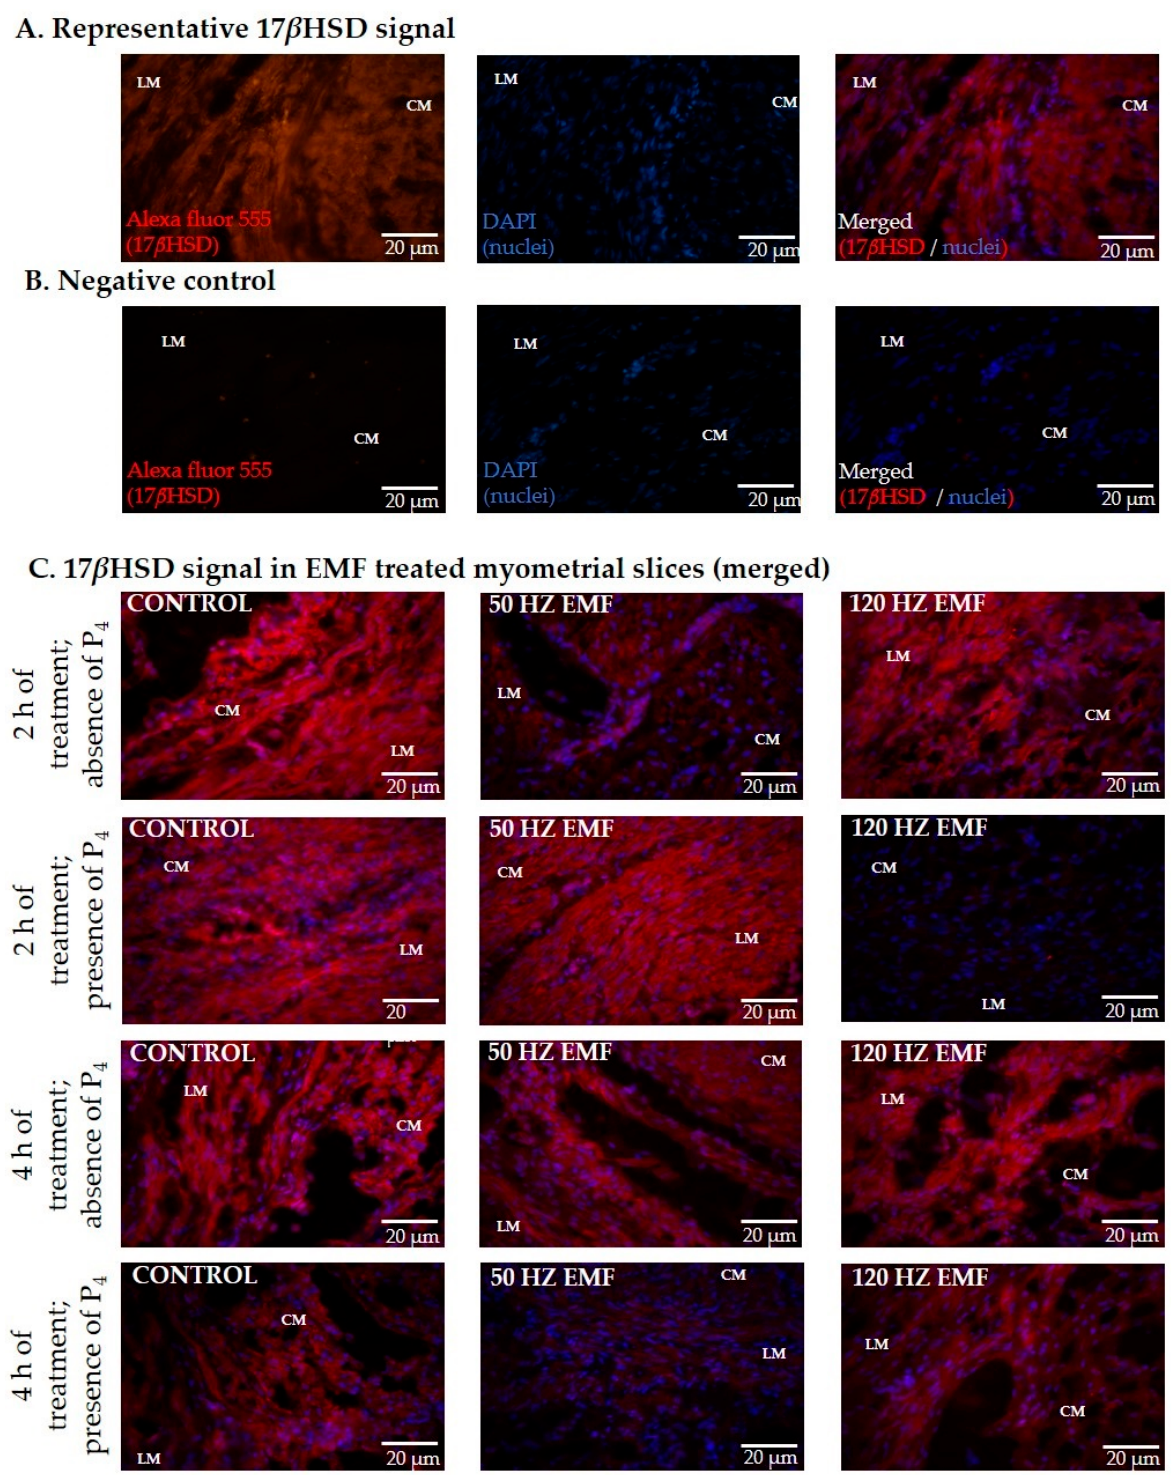
Figure 3. Randomly selected representative photographs of immunodetection of 17 β -hydroxysteroid dehydrogenase (17 β HSD) in porcine myometrium of pigs during the peri-implantation period exposed in vitro to an electromagnetic field (EMF) at 50 and 120 Hz for 2 and 4 h in the presence or absence of P 4 . The panels show representative 17 β HSD signal ( A ), negative control ( B ), and 17 β HSD signal in EMF-treated myometrial slices (merged) ( C ). Magnification 400 × . CM—circular muscle; LM—longitudinal muscle. The nuclei are stained with DAPI (blue) and binding sites are visualized with Alexa Fluor 555 (red).